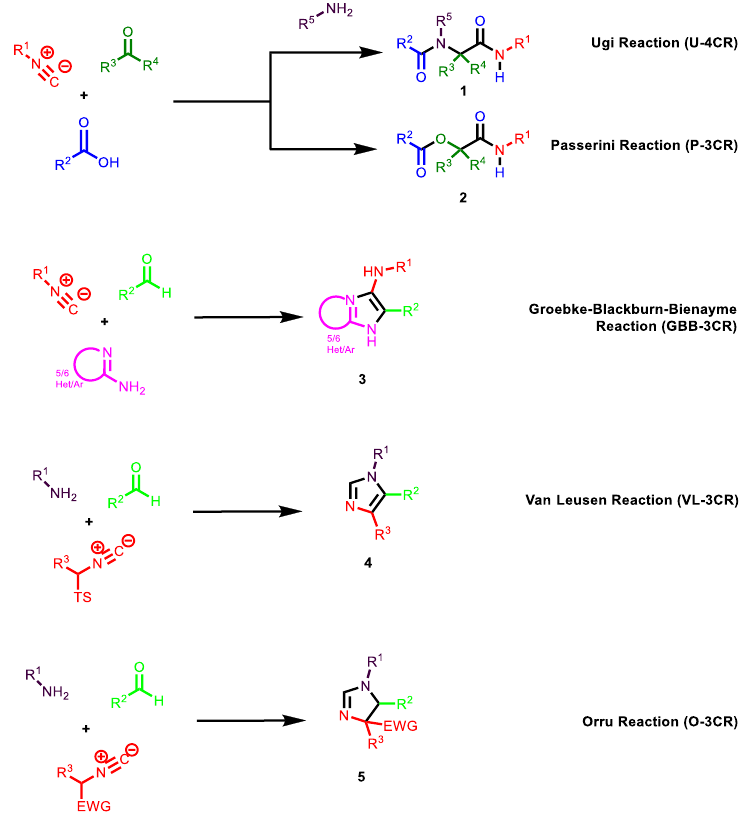
Figure 2. Isocyanide-based multicomponent reactions.